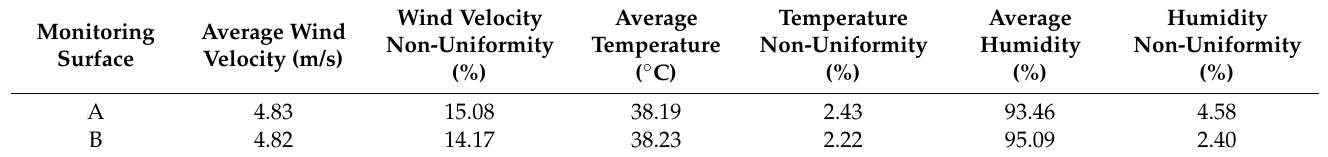
Table 2. Average values and non-uniformity of indicators on the monitoring